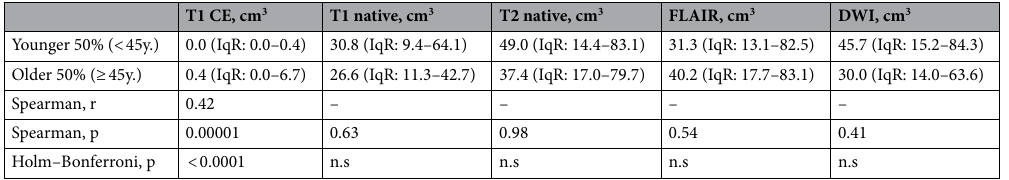
Table 1. Median tumor volume in various MRI sequences before resection.